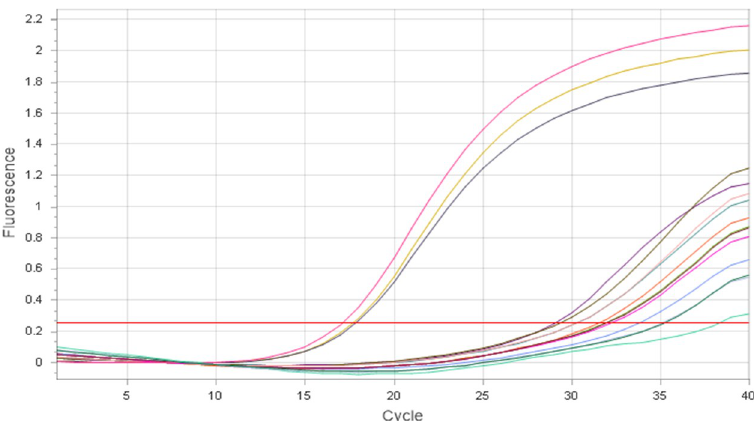
Fig 5. Amplification curve of A . pleuropneumoniae ATCC 27090 DNA: (1) from cells killed by boiling (PMA treated– 27.5 Cq); (2, 3) from cells killed with Ecas4 anolyte at 5% (no PMA treatment– 26.0 Cq) and 10% (no PMA treatment– 30.4 Cq); (4) from a viable (live) control (15.3 Cq). qPCR was performed with 1.0 μ M apxIVA gene